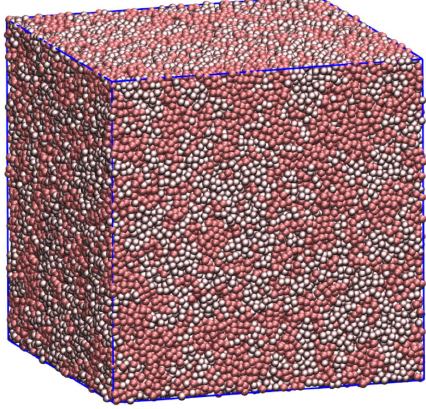
Figure 3. Snapshot of a well-equilibrated blend (flexible chains pink, stiff chains gray). The chains remain well mixed and isotropic throughout the